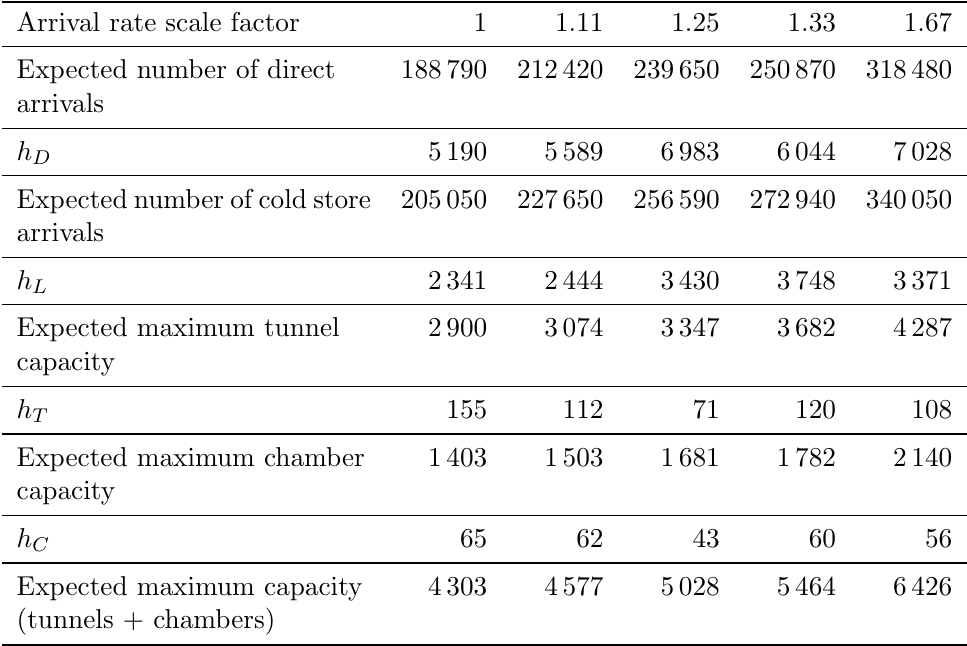
Table 5: Estimated values for the output parameters with different arrival rates. interval half-width, based on the t -distribution.